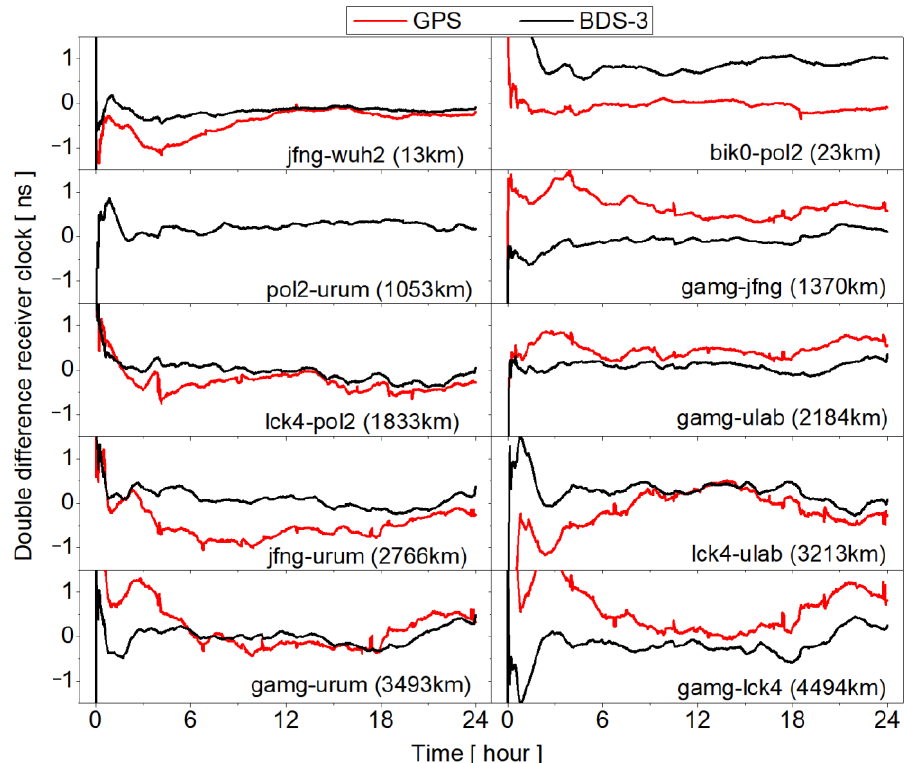
Figure 11. Double-differenced receiver clock series in MJDN 59511; the black and red lines represent GPS and BDS-3 receiver clocks, respectively.